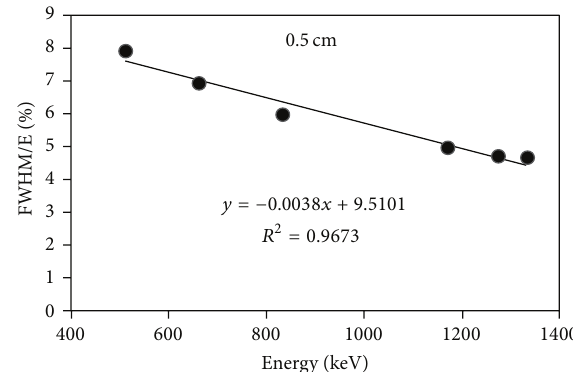
Figure 9: Energy resolution of the NaI(Tl) detector obtained for 0,5 cm